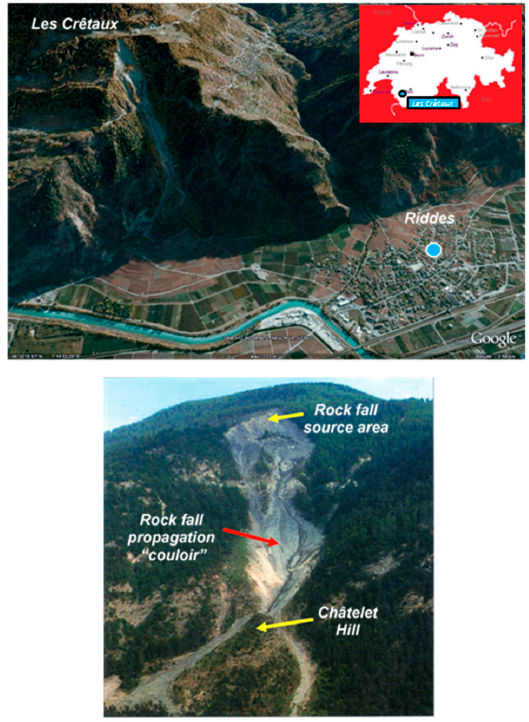
Figure 11. Area of Les Crêtaux, Canton of Valais (Switzerland). Top : location and aerial view of the study site (sources: www.petiteviree.com, Google Earth). Bottom : front view of the rock fall source area and the corridor located just below (source: [17]).